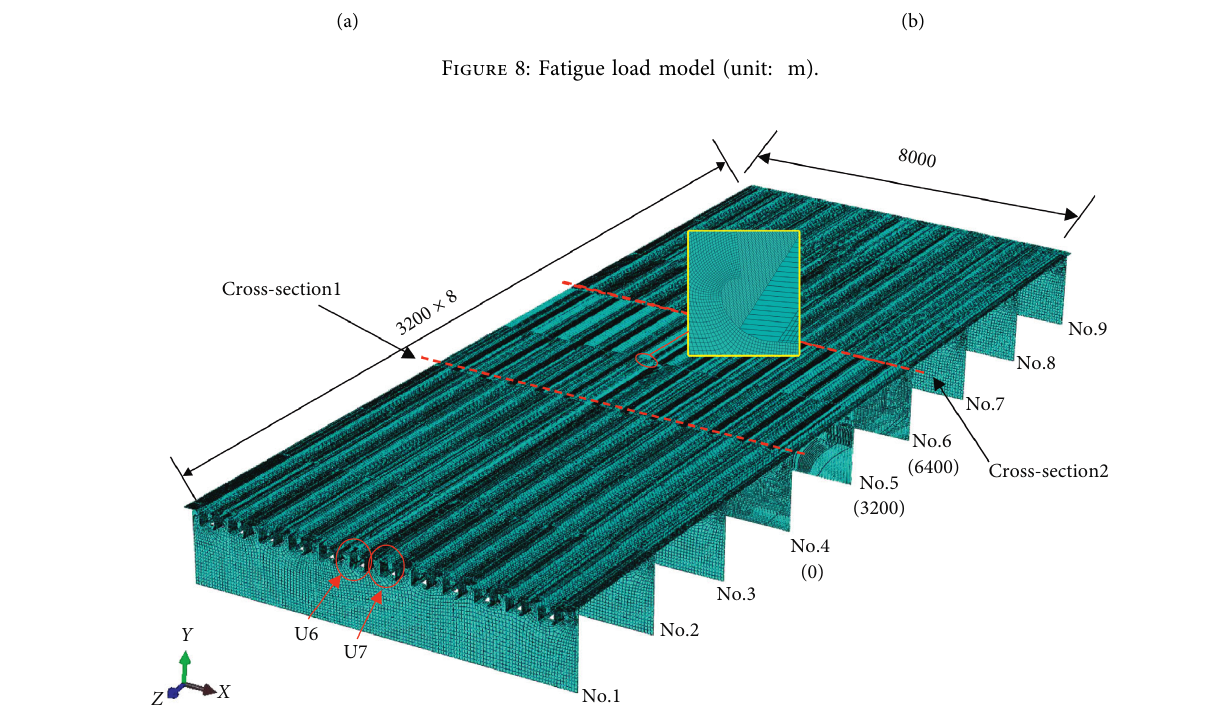
Figure 9: FE model of orthotropic steel deck (unit: mm).